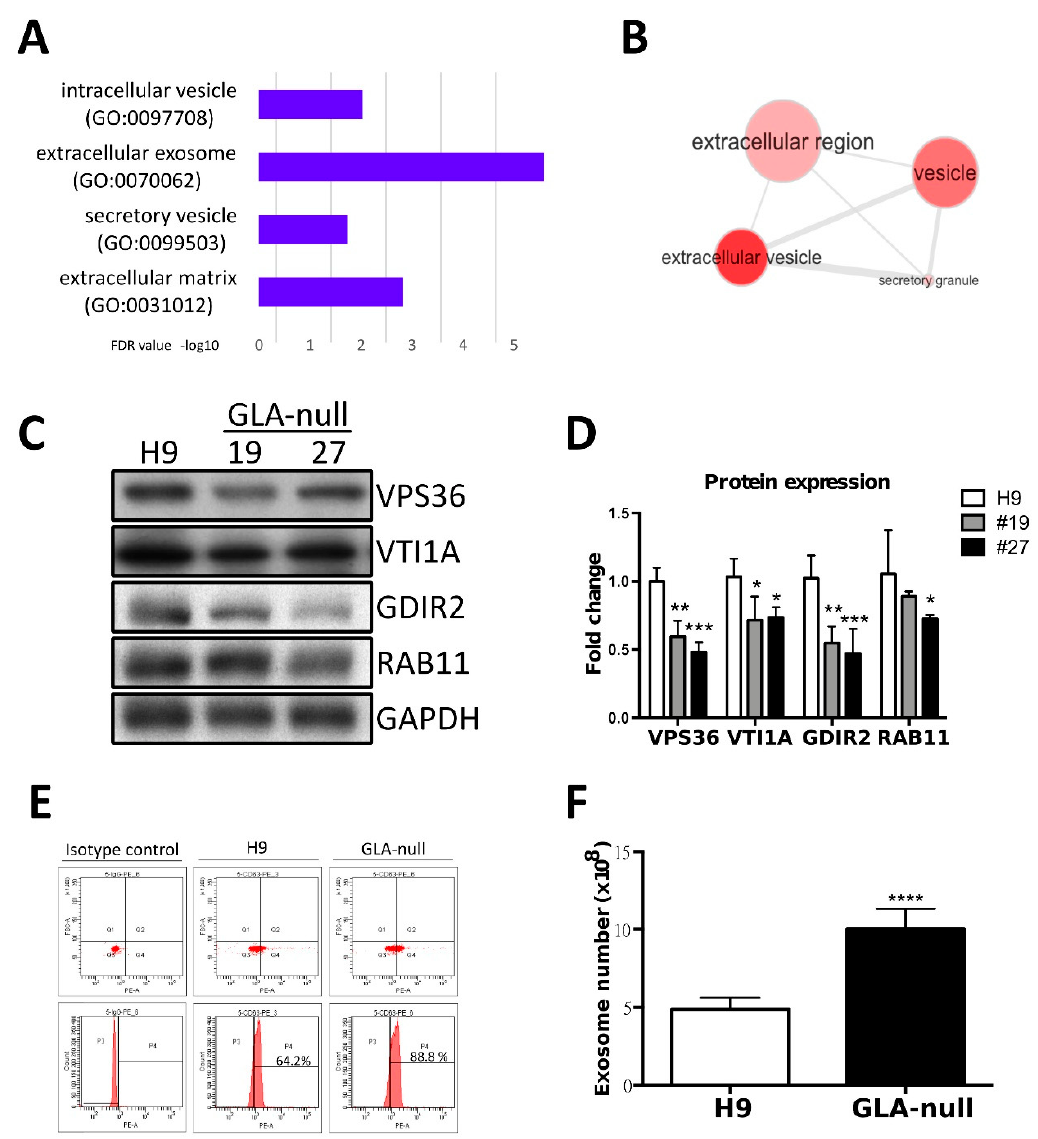
Figure 4. Proteomic analysis of GLA-null CMs. ( A ) The most enriched cellular component GO terms in the list of 60 genes downregulated in GLA-null CMs. ( B ) Visualization of the most enriched cellular component GO terms using REVIGO software. ( C ) Western blot showing expression of the mediators of vesicular tra ffi cking in GLA-null CMs #19 and #27 as compared to wild type control (H9). GAPDH served as a loading control. ( D ) Quantitation of expression of proteins annotated as the mediators of vesicular tra ffi cking. The data are presented as mean ± standard deviation error bars from three independent experiments. ( D ) Flow cytometric analysis of CD63 expression in H9- and GLA-null CM-derived exosome isolated with magnetic beads directly from cell culture medium. ( E ) Quantification of exosome numbers in the supernatant from H9 and GLA-null